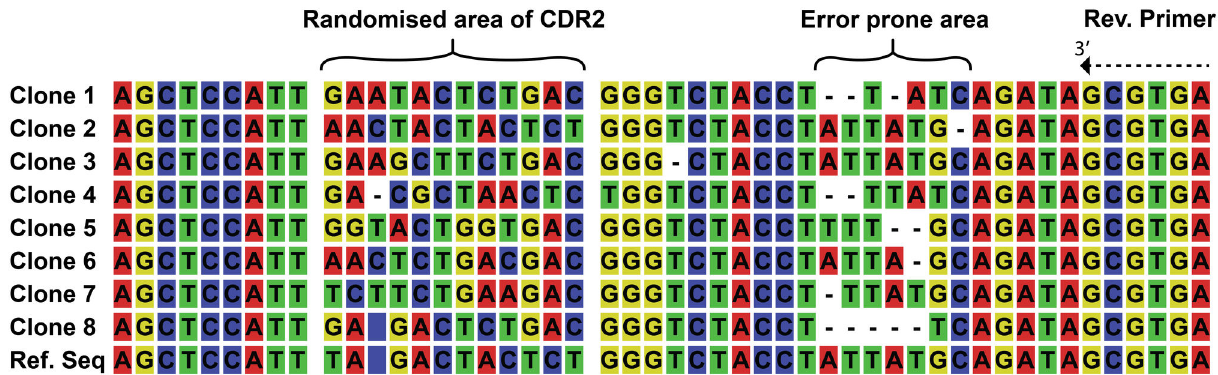
Figure 4. Sequences showing an error prone repeat close to primer annealing site. The sequencing data from eight clones with errors and a reference sequence showing the CDR2 and immediate downstream region. The nucleotides composing the randomized region of CDR2 are indicated at the top along with the nucleotides matching the 3’ end of the reverse primer used for the generation of the CDR2 insert. Eight of the shown clones have errors and all of the errors have occurred in the area between the randomized region of CDR2 and 3’ end of the reverse primer used in the generation of the CDR2 insert. Especially the “TATTAT” repeat seems susceptible to errors.